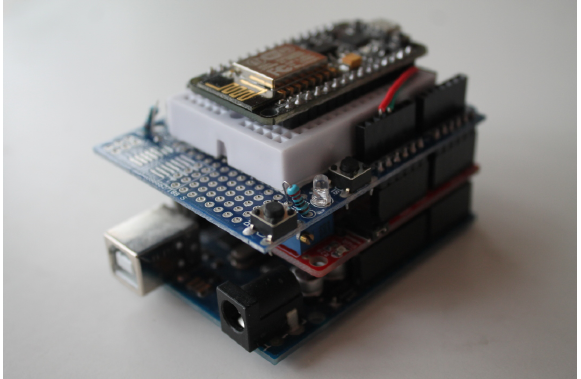
Figure 5. The stack of three Arduino-compliant boards: below the Arduino, the Olimex acquisition board in the middle, the protoboard hosting the ESP12e on the